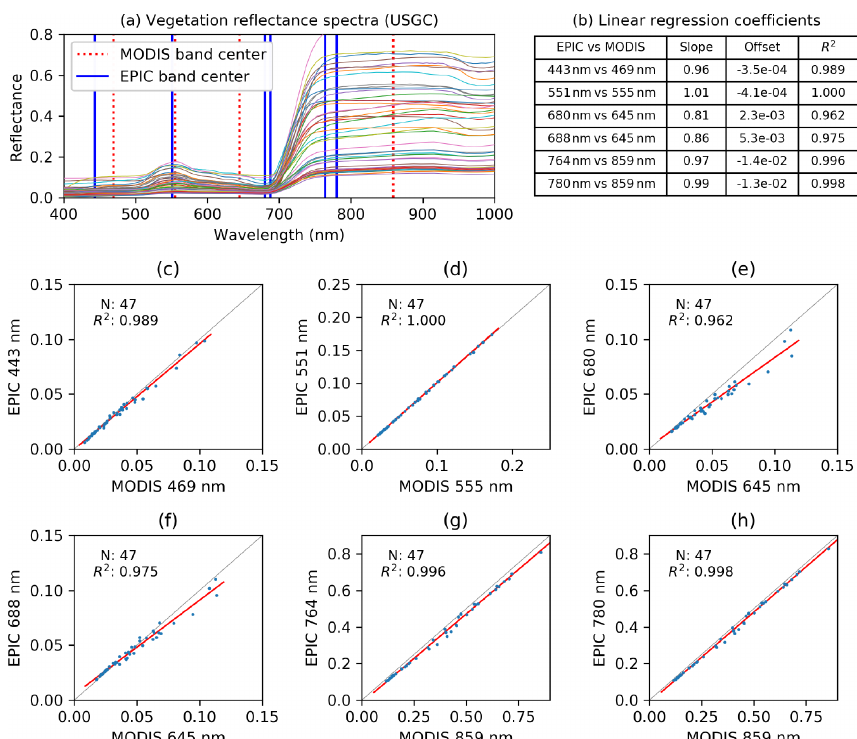
Figure 6. Determination of surface reflectance from MODIS surface albedo products. (a) USGS reflectance spectra for different vegetation samples and (b) statistics for regression (i.e., slope, offset, and coefficient of determination, R 2 ) of reflectance between different EPIC bands, marked as red dotted lines in (a) , and the respective closest MODIS bands, marked as blue lines in (a) , according to the spectral library. (c–f) Scatterplots of reflectance in each EPIC band versus reflectance in the corresponding MODIS bands. Linear regression lines are shown in red.